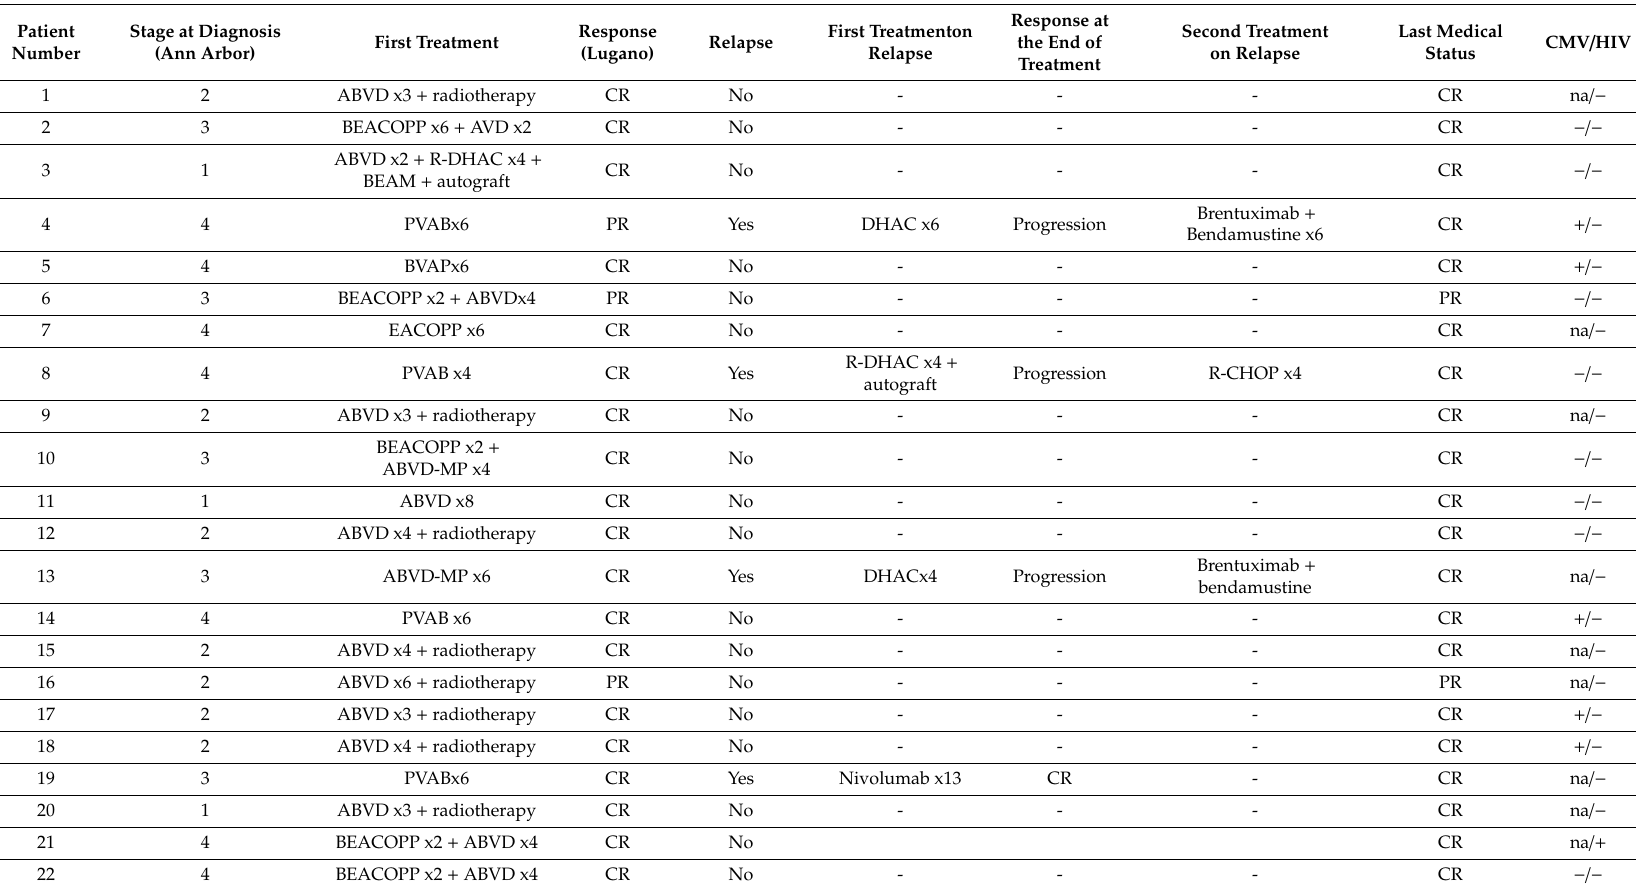
Table 1. Clinical characteristics of the HL cohort. The table describes the patients’ subtype according to the Ann Arbor scoring system, the treatment, and the outcome. The cohort of 22 patients is composed of 12 men (55%) and 10 women (45%). Patients were between 19 and 69 years